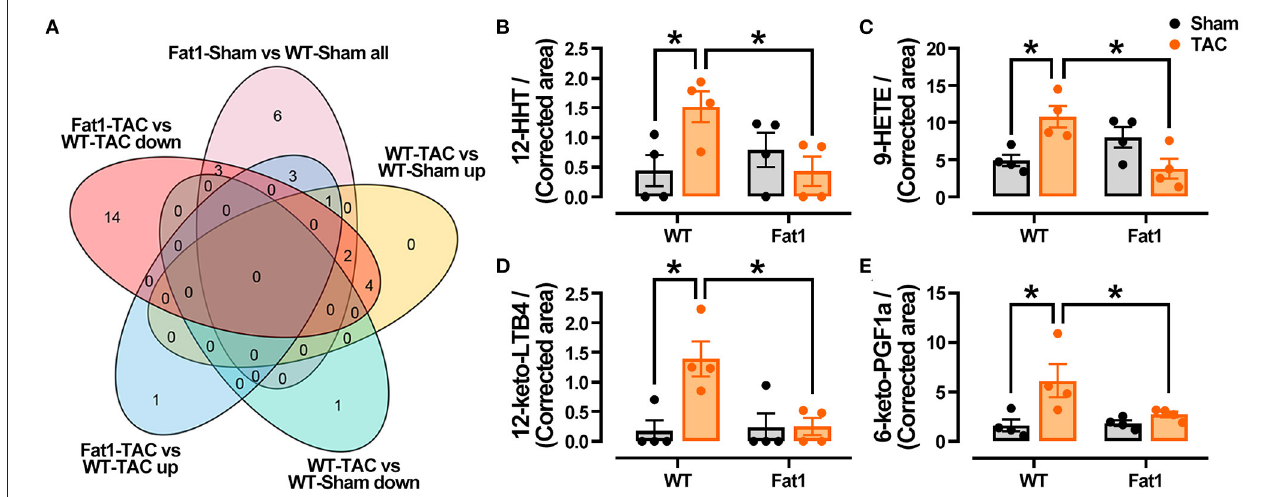
FIGURE 6 | Fat-1 Oxylipin production in pressure overload hearts. (A) Venn diagram displaying the oxylipins that were decreased (increased) by pressure overload, were increased (decreased) by fat-1 transgene under pressure overload conditions. Four oxylipins including 12-HHT (B) , 9-HETE (C) , 12-keto-LTB4 (D) , and 6-keto-PGF1a (E) were identified via Venn diagram analysis. 12-HHT, 12(S)-hydroxyheptadeca-5Z,8E,10E-trienoic acid; 9-HETE, 9S-hydroxy-5Z,7E,11Z,14Z-eicosatetraenoic acid; 12-keto-LTB4, 12-keto-leukotriene B4; 6-keto-PGF1a, 6-keto-prostaglandin F1alpha. N = 4 for each group. * P < 0.05 between